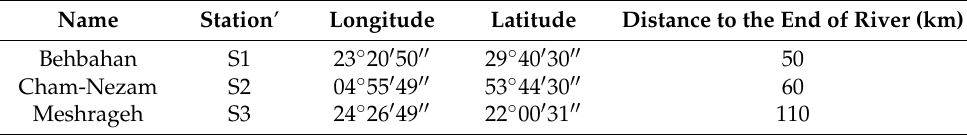
Table 4. Specifications of river water quality monitoring stations.